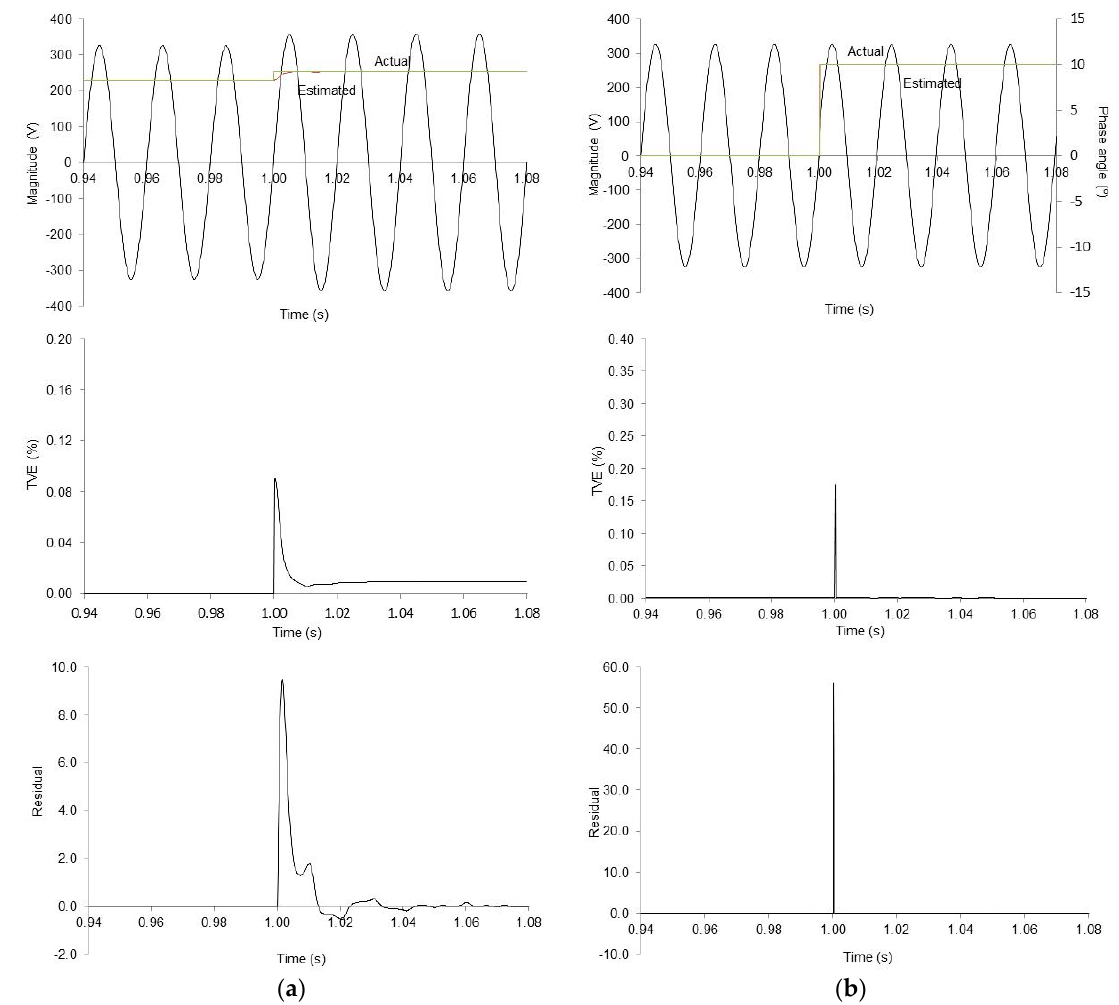
Figure 6. ( a ) Estimated magnitude, residual and TVE during a 10% step change in amplitude, and ( b ) estimated phase angle and TVE during a 10° step change in phase angle.